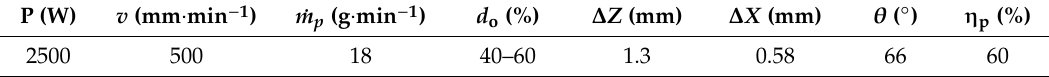
Figure 13. Scheme of the extra clad deposition strategy validation during the manufacturing of a wall. Table 3. Validation strategy of Alloy 718 variable thickness walls. Main deposition parameters.